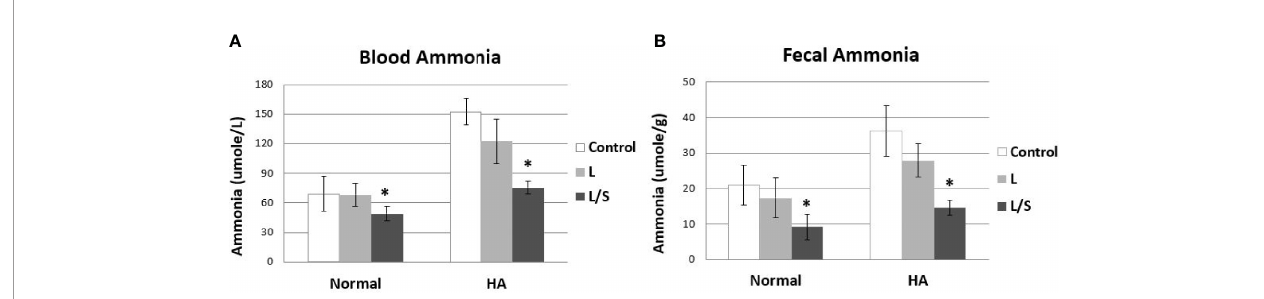
FIGURE 3 | In vivo ammonia-removal ef fi cacy of L. reuteri JBD400 with the assistance of the symbiotic partner S. rubneri JBD420. C57BL/6 mice were daily administered saline (Control), pure culture of L. reuteri JBD400 (L), or symbiotic pair of L. reuteri JBD400 and S. rubneri JBD420 (L/S), as indicated at dose of 10 9 CFU (n=5 per group) for 2 weeks. After administration of the indicated culture for 2 weeks, each group of mice was injected either saline as control (Normal) or NH 4 Cl at the dose of 100 mg/kg body weight for inducing Hyperammonemia (HA). The ammonia levels in the blood (A) and feces (B) were collected after 1 hour and quantitated by using a commercial ammonia assay kit. All data were expressed as the mean ± SD, as indicated. The statistical comparisons were analyzed using ANOVA (one-way). All differences were considered statistically signi fi cant if p < 0.05. * indicates signi fi cant difference compared to